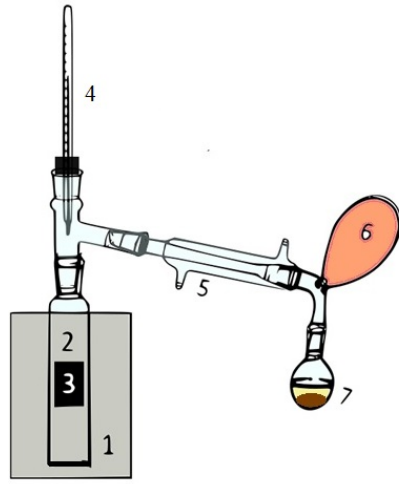
Figure 1. Schematic catalytic pyrolysis setup. 1—oven, 2—quartz tubular reactor, 3—catalyst, 4—thermometer, 5—condenser, 6—latex balloon, 7—flask.